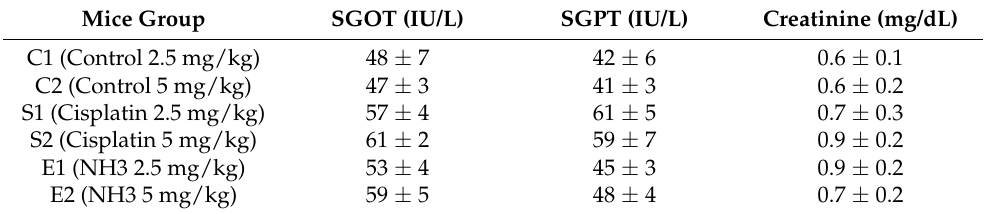
Table 6. Biochemical study parameters. Mice Group SGOT (IU/L) SGPT